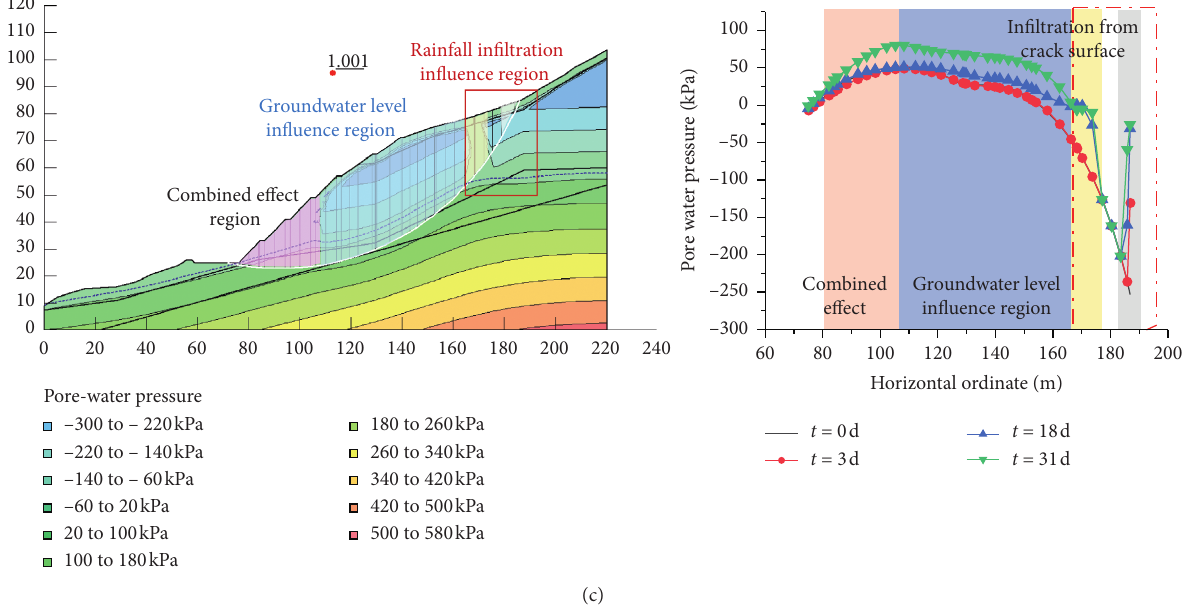
Figure 15: The potential sliding surface and pore water pressure distribution of the cracking slope with the permeability ratio of (a) 0.1; (b) 1.0; (c) 10.